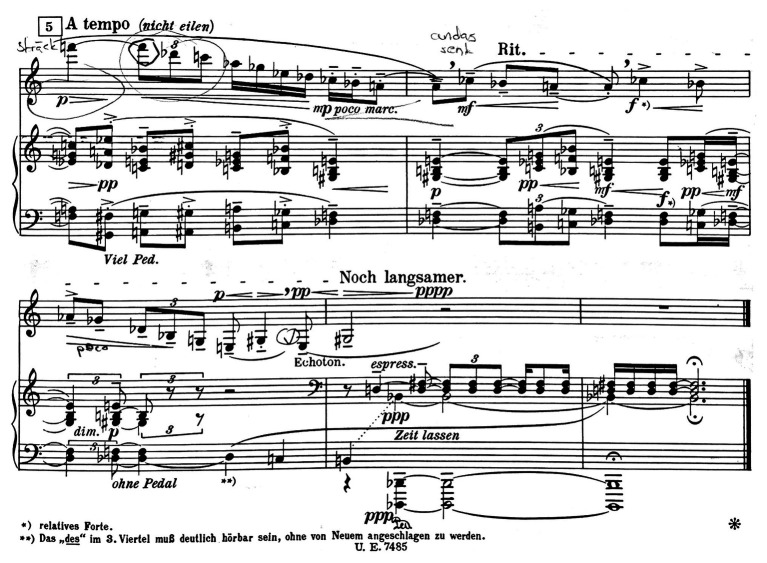
Bars 5–9 of the second movement in Alban Berg’s Vier Stücke op.5 (Berg, 1913, p. 5)